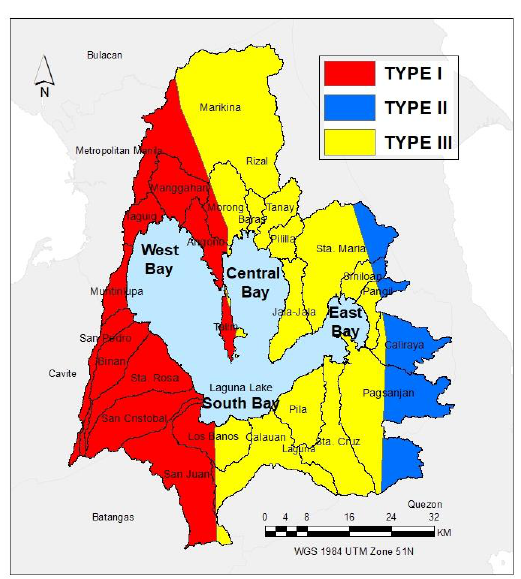
Figure 1 . Climate map, subbasins, and relative locations of the bays of Laguna de Bay watershed.